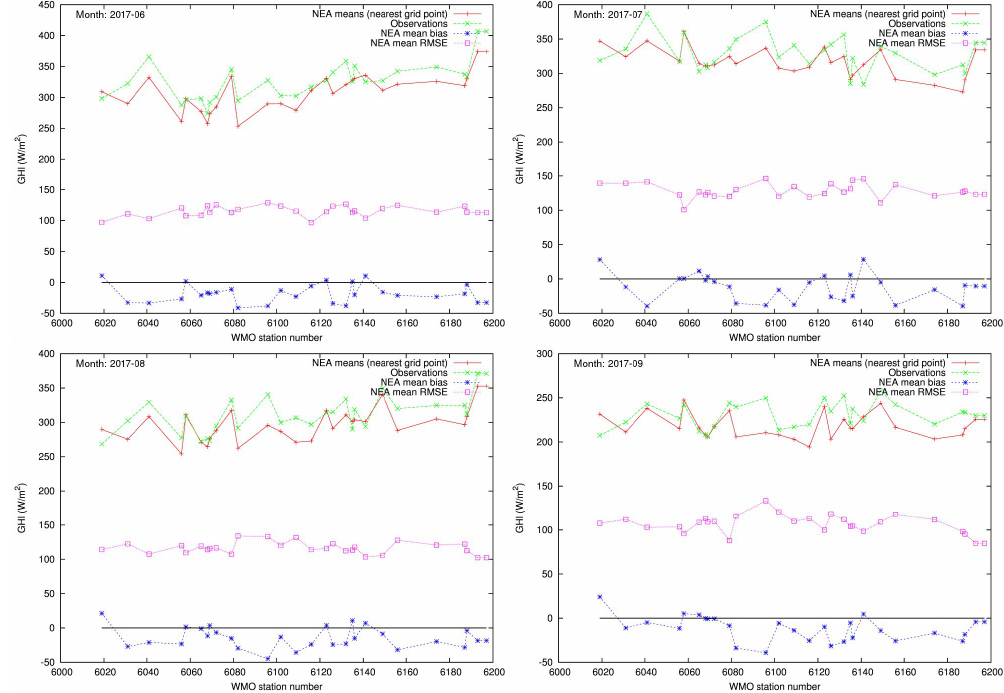
Figure 9. Monthly mean observed (green curves) and modelled (red curves) GHI for each station in Denmark for the months of June, July, August and September in 2017, shown as graphs with the station numbers on the x -axis. Bias (blue curves) and RMSE (magenta curves) are also shown for each